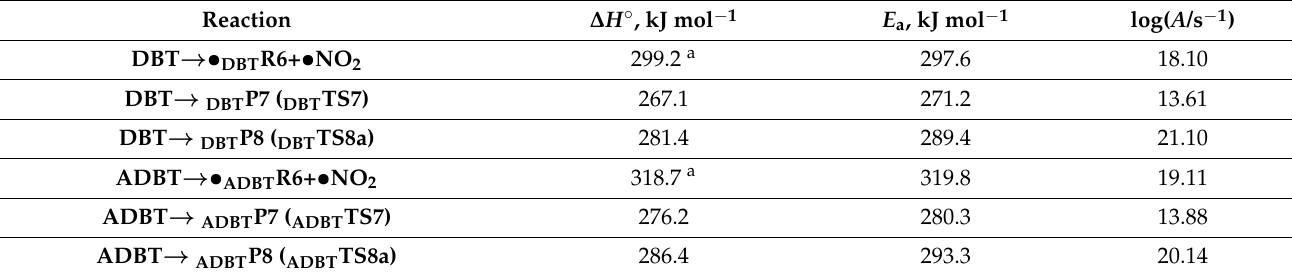
Table 2. The calculated kinetic parameters of the primary gas-phase decomposition reactions for DBT and ADBT . The rate-limiting transition state is shown in parentheses.